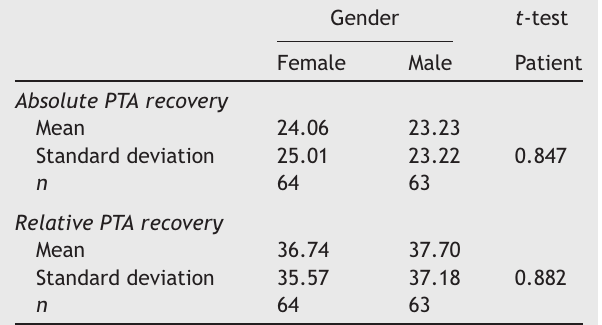
Independent Student’s t -tests between genders for recovery rates.